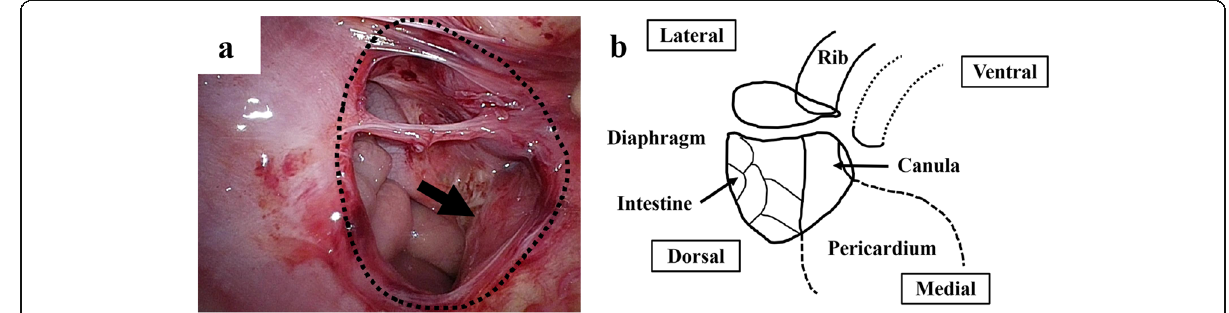
Fig. 3 The orifice of the diaphragmatic hernia and cannula. Following reduction of the herniated small intestine, the diaphragmatic defect (dotted line) was confirmed just lateral to the VAD cannula (black arrow). The defect was 3 × 2 cm in